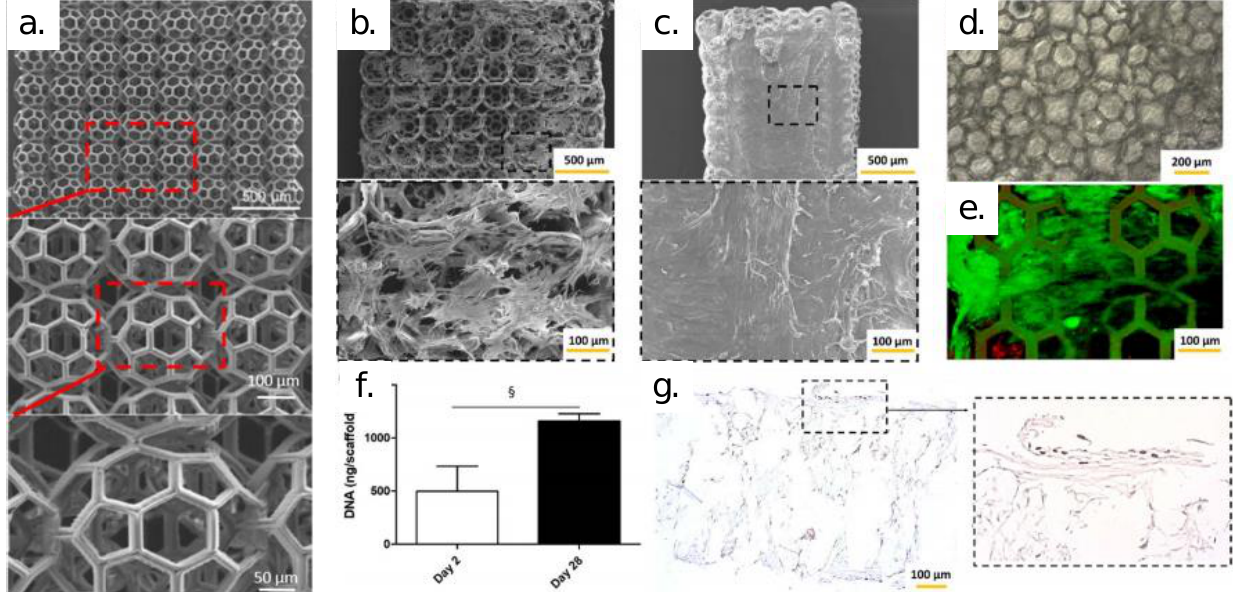
Figure 17. TPP-produced PTMC-based scaffolds support cell invasion and proliferation: ( a ) SEM images of the tri-layered PTMC-based scaffold at various magnifications (×50, ×150 and ×300). SEM images of cell-seeded scaffolds day 2 ( b ) and day 28 ( c ) post seeding. ( d ) Bright field and ( e ) live/dead illustrations of the colonized scaffold at day 28. ( f ) Cellular proliferation quantified by DNA assay (§ indicates statistical significance) and ( g ) Ki67 immunostaining (nuclei of positive proliferative cells are stained in black). Adapted with permission [71]. Licensed under a Creative Commons Attribution 4.0 International license.